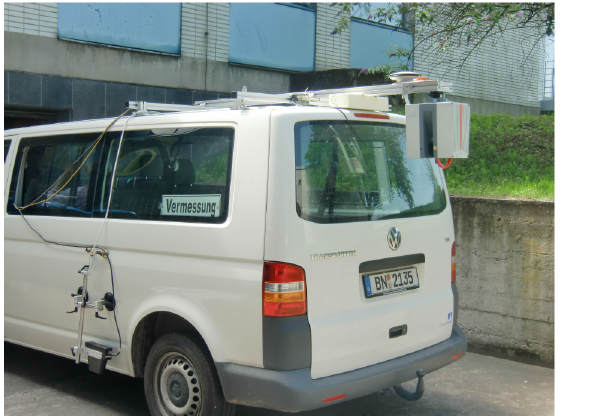
Figure 5. The used Mobile Mapping System with laser scanner, odometer, GNSS receiver and inertial measurement unit.